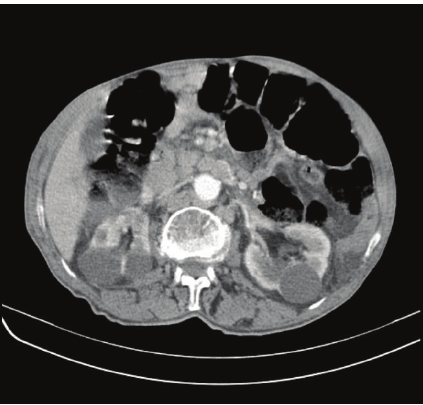
nodes in the retroperitoneum. The patient also presented bilateral renal